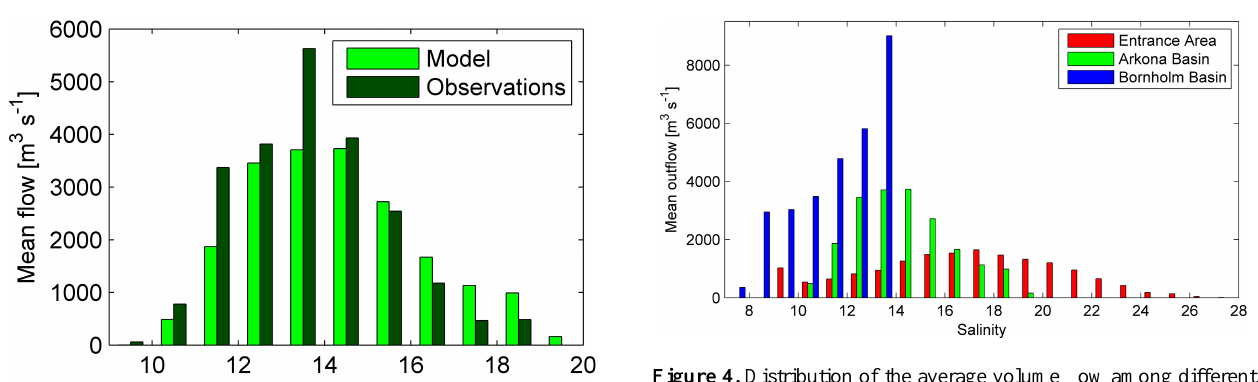
Figure 4. Distribution of the average volume flow among different salinities for the modeled deepwater flows from the entrance area, the Arkona Basin and the Bornholm